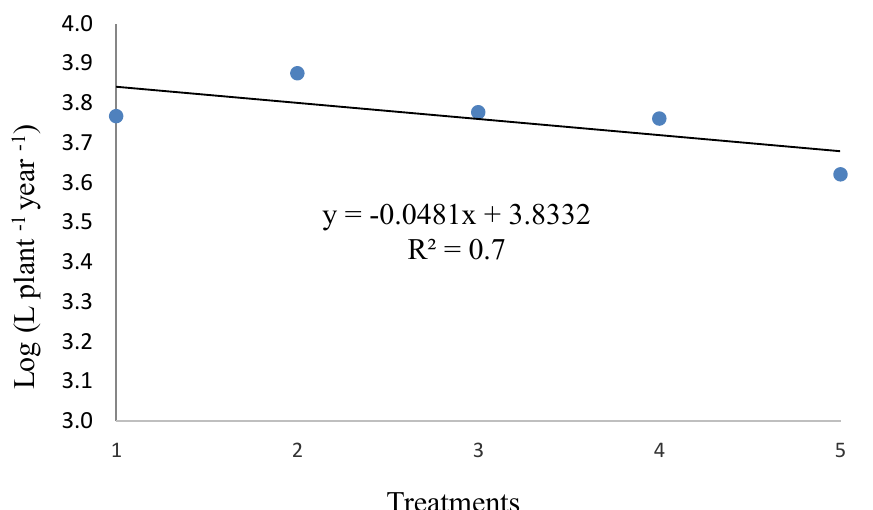
Figure 4. Adjusted linear model (R 2 = 0.70; p = 0.075) to describe the relationship between treatments (T1—0.0 kg; T2—0.5 kg; T3—1.0 kg; T4—2.0 kg; and T5—4.0 kg of biochar per plant) and log accu- mulated water volume applied per plant (L) in 2017 and 2018, Paraipaba (CE), Brazil.